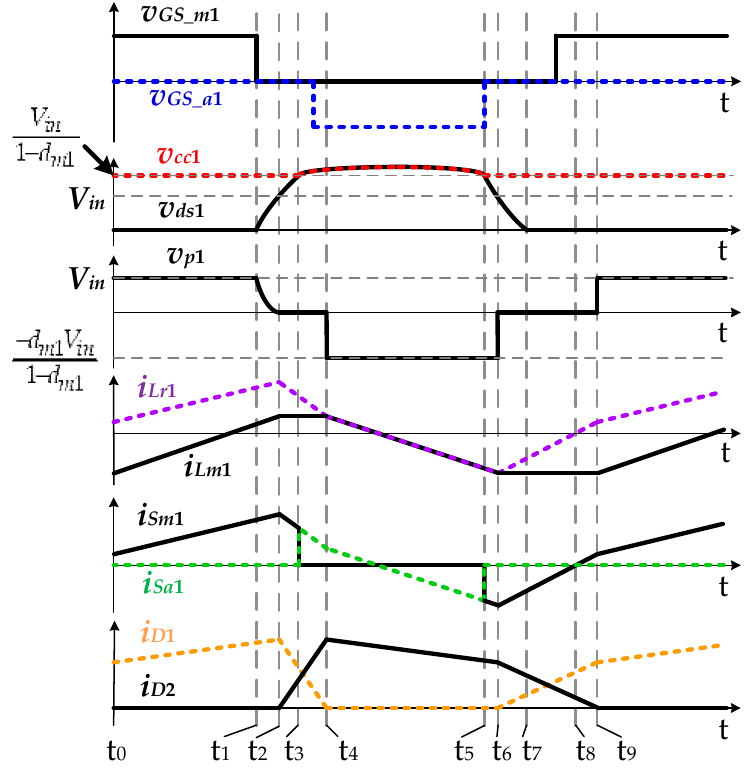
Figure 5. The theoretical timing diagram of key components in one switching period.